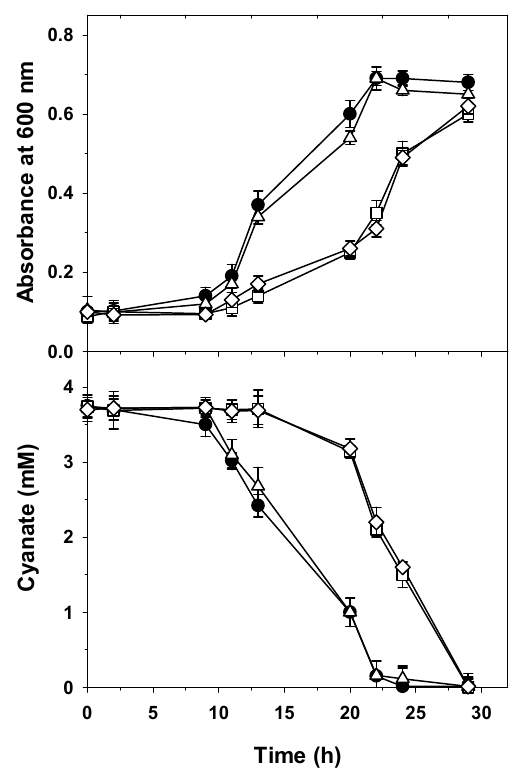
Figure 4. Growth and cyanate consumption in media with cyanate of the P. pseudoalcaligenes CECT5344 wild-type ( (cid:8) ) and the single or double mutant strains CynX − ( (cid:52) ), CynBD − ( (cid:3) ), and CynX − / CynBD − ( ). Cells were grown in the minimal medium M9 with 4 mM cyanate as the sole nitrogen source, and at the indicated times, the bacterial growth (A 600 ) and cyanate concentration in the media were determined. Error bars show standard deviations of three independent replicates.